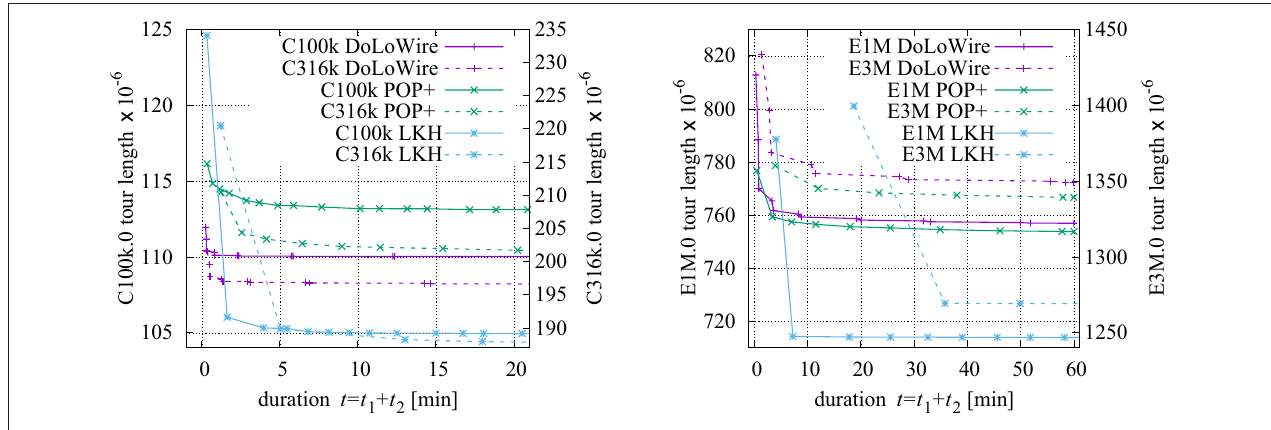
1,500, maxSP 300). See text for details. = =